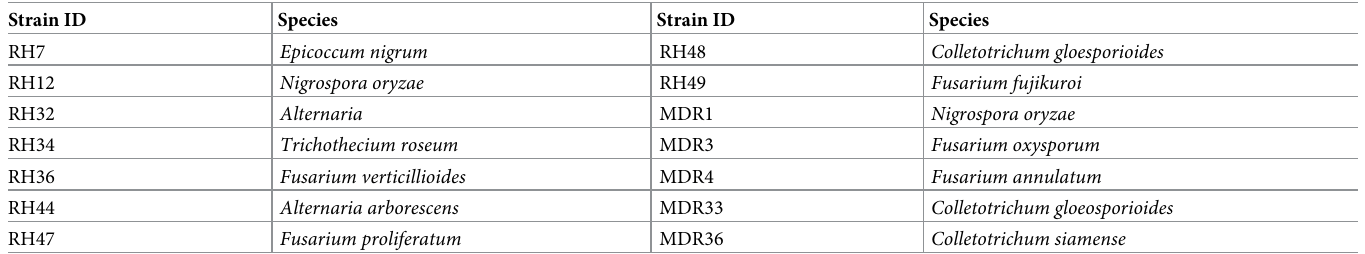
Table 1. Endophytic fungal strains used in the